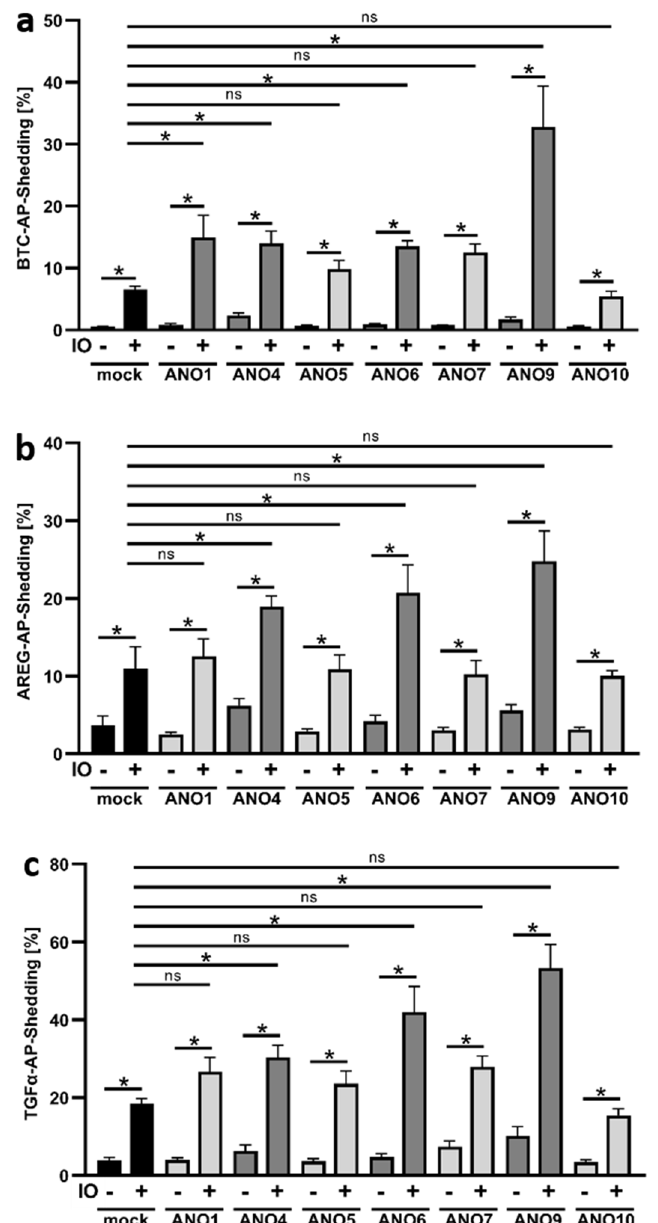
Figure 1. Ionomycin induces increased shedding of BTC, AREG, and TGF α in ANO4-, ANO6-, and ANO9-overexpressing cells. HEK293T cells were co-transfected with an ANO plasmid or mock vector (black columns) and the AP-tagged ADAM10/17 substrates ( a ) betacellulin (BTC), ( b ) amphiregulin (AREG), or ( c ) TGF-alpha (TGF α ). Cells were stimulated with ionomycin (IO, 1 µ M) for 30 min and analyzed for the release of soluble BTC, AREG, or TGF α via AP-assay. * indicates a significant increase compared to corresponding unstimulated cells or stimulated mock control (dark grey columns), and ns indicates no significant difference (light grey columns) (n = 6; * p < 0.05; ± SEM). Data were analyzed by one-way ANOVA and Holm–Sidak multiple comparison post hoc test.